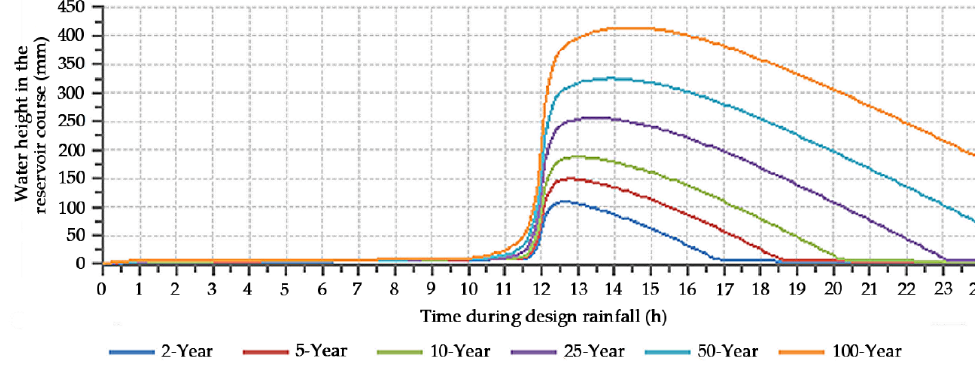
Figure 13. Water height in the reservoir course for the Technology Centre in Florianópolis.